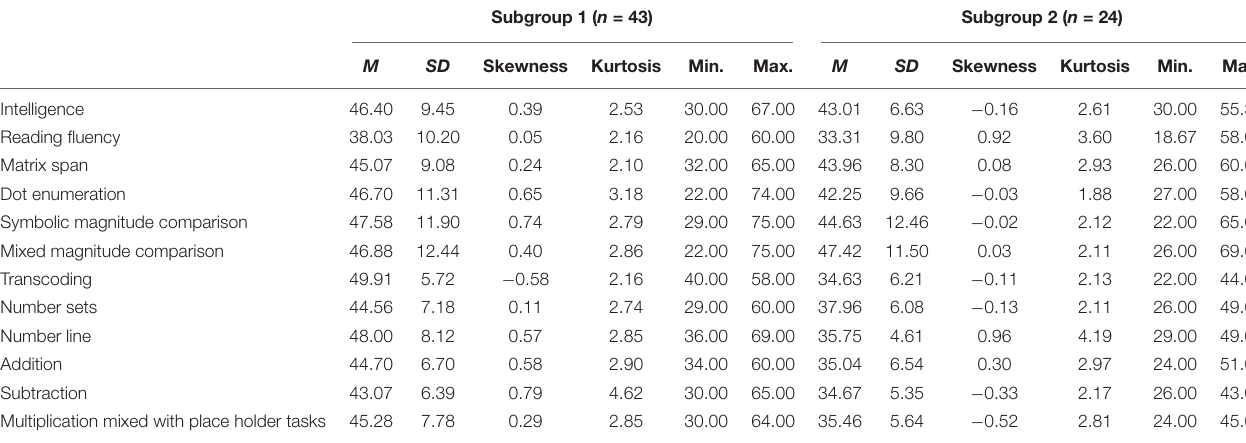
TABLE 4 | Descriptive statistics of the HRT 1-4 sample—clustered by subtests.